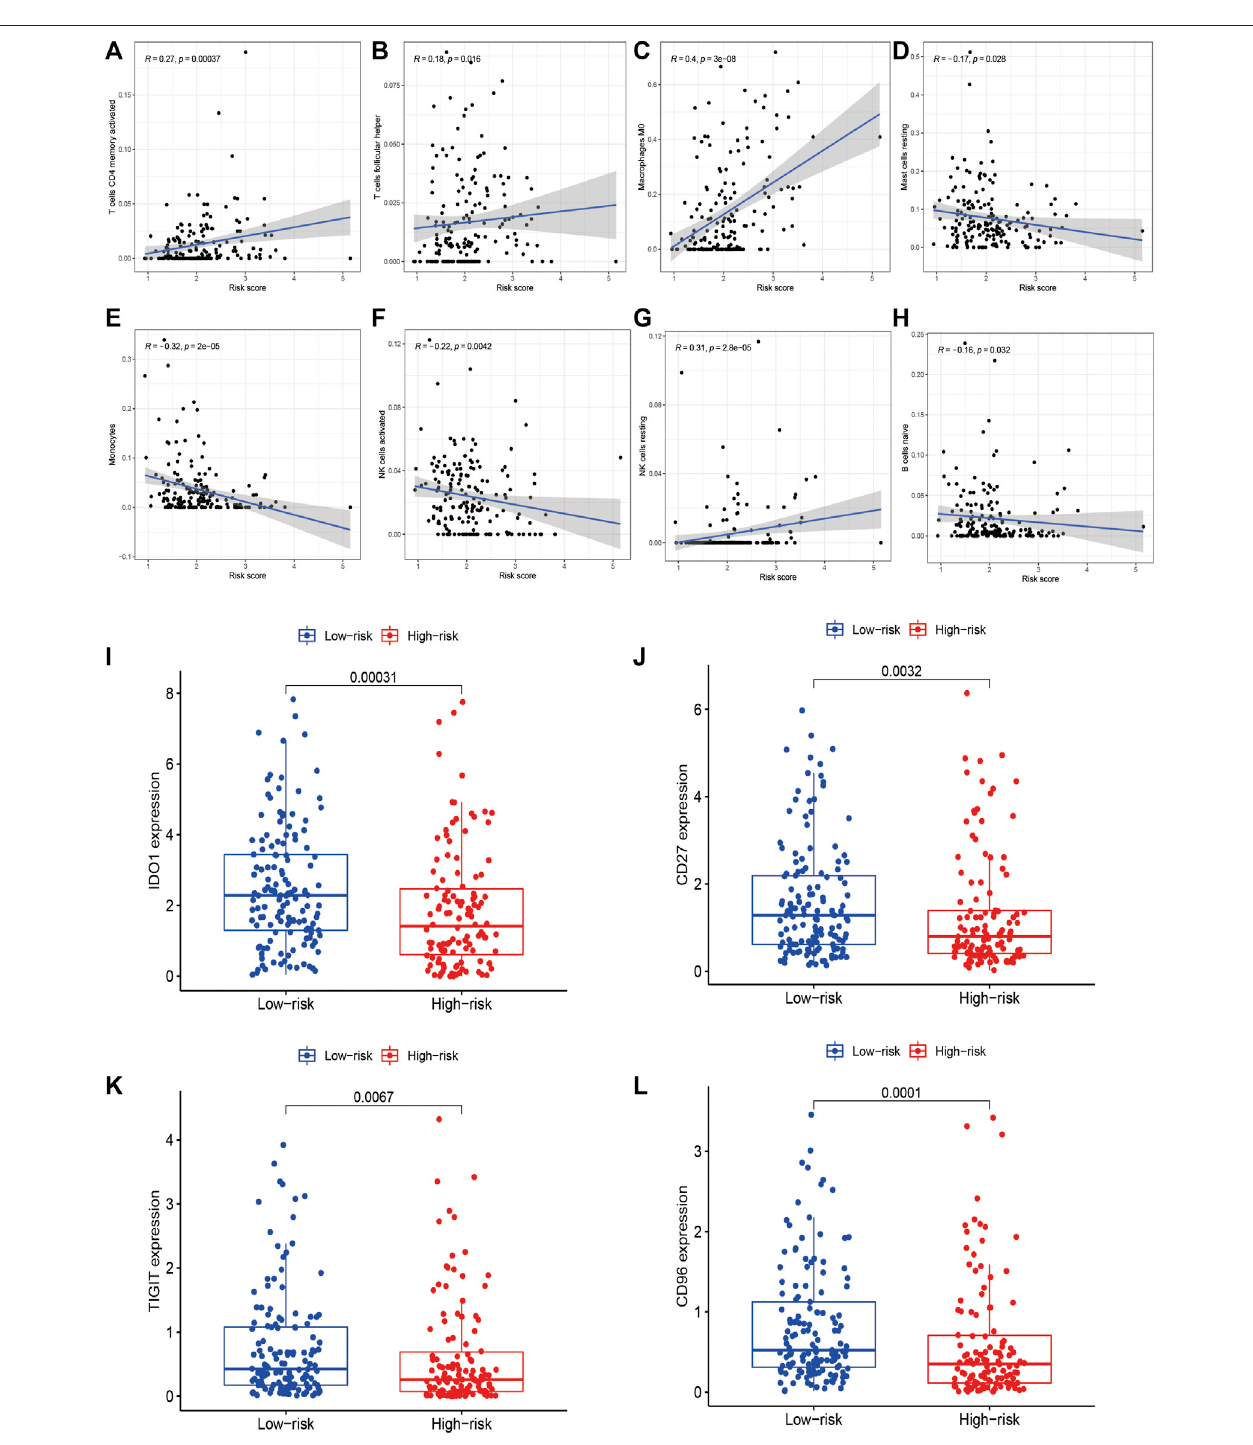
FIGURE 10 | The correlations between the risk signature and immune microenvironment in STS. (A – H) The correlations between the risk score and immune cells in fi ltration. The risk score was positively related to (A) activated memory CD4 + T cells, (B) follicular helper T cells, (C) resting NK cells, and (D) M0 macrophages, while negatively related to (E) activated NK cells, (F) resting mast cell, (G) monocytes, and (H) naïve B cells. (I – L) The correlations between the risk signature and the expression of immune checkpoint (I) IDO1, (J) CD96, (K) TIGIT and (L) CD27.